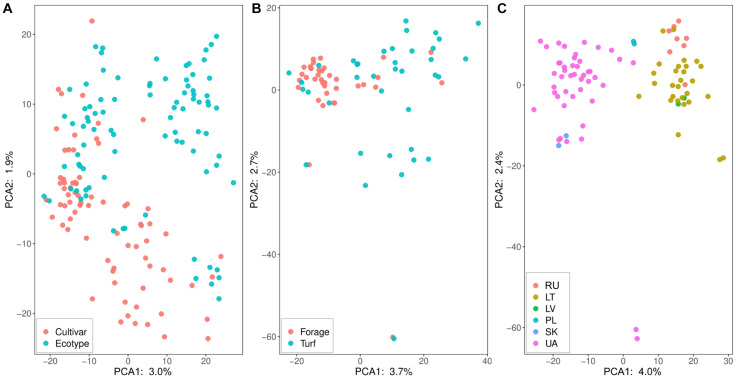
Principal component analysis (PCA) of 197 perennial ryegrass cultivars and ecotypes based on genotyping-by-sequencing data. (A) shows the dispersion of cultivars and ecotypes where cultivars are indicated in red and ecotypes in blue dots. The dispersion of cultivars based on the type is shown in (B), where forage type cultivars are represented in red dots and blue dots indicate turf type cultivars. (C) demonstrates the distribution of the ecotypes according to their country of origin. Countries are presented in two-letter codes: RU, Kaliningrad region, Russian Federation; LT, Lithuania; LV, Latvia; PL, Poland; SK, Slovakia; and UA, Ukraine.